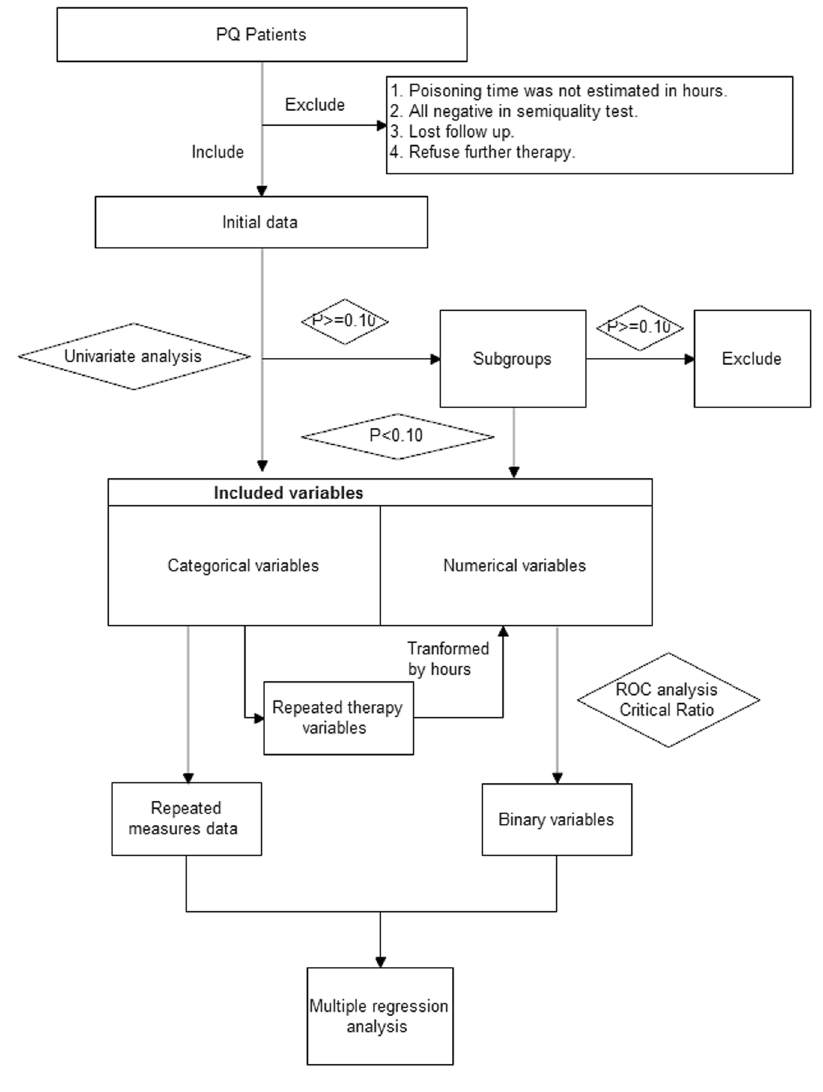
Figure 2. Flowchart of the study